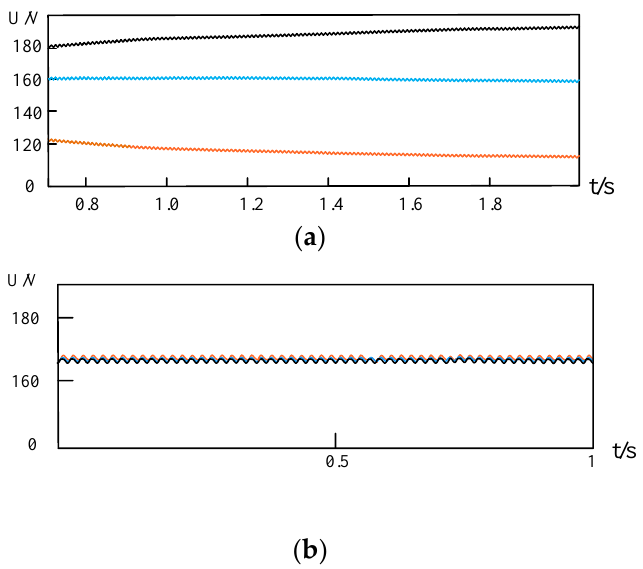
Figure 10. Current DQ decoupled double closed-loop control. ( a ) When the equivalent resistance on the DC side is inconsistent, the voltage cannot be balanced. ( b ) When the equivalent resistance on the DC side is consistent, the voltage can be balanced.